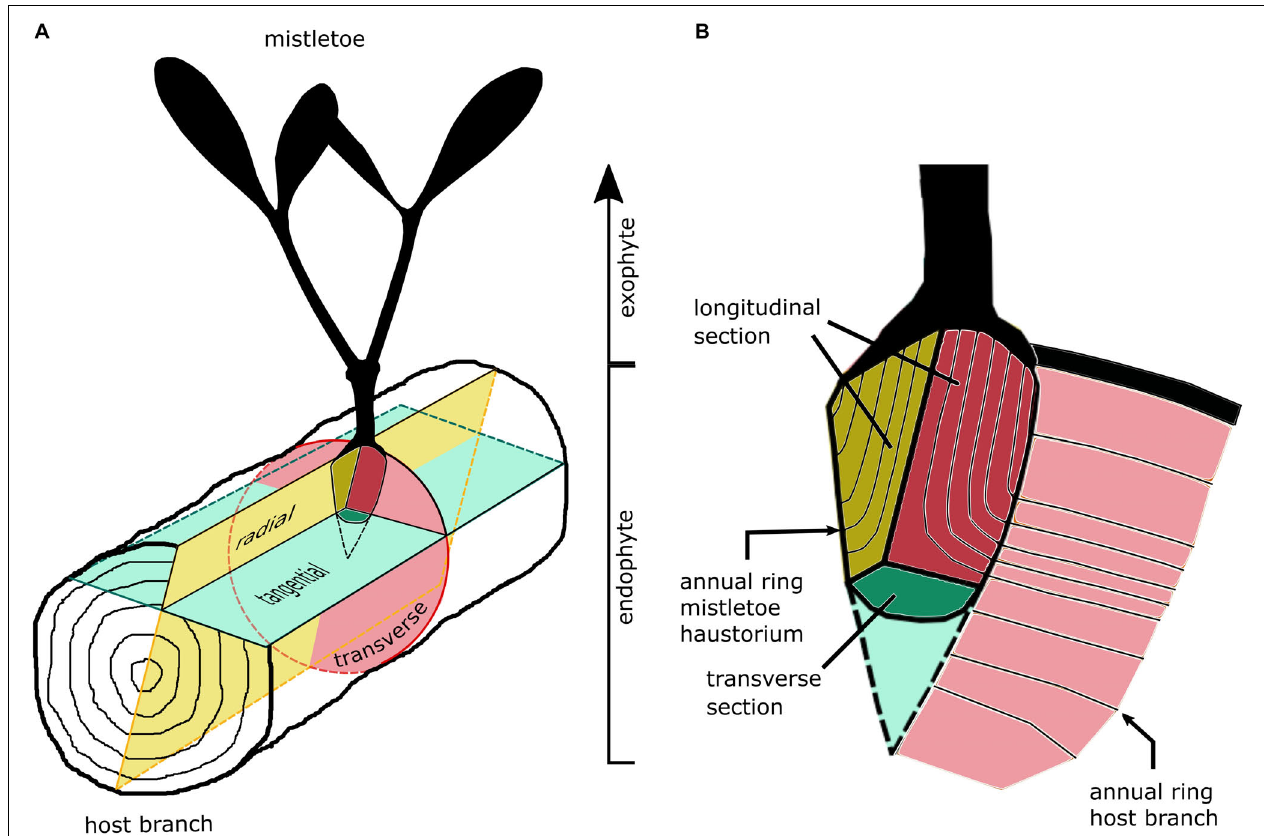
FIGURE 2 | Sketches of the section planes of (A) host branch and (B) the primary sinker of the mistletoe haustorium in the host wood.